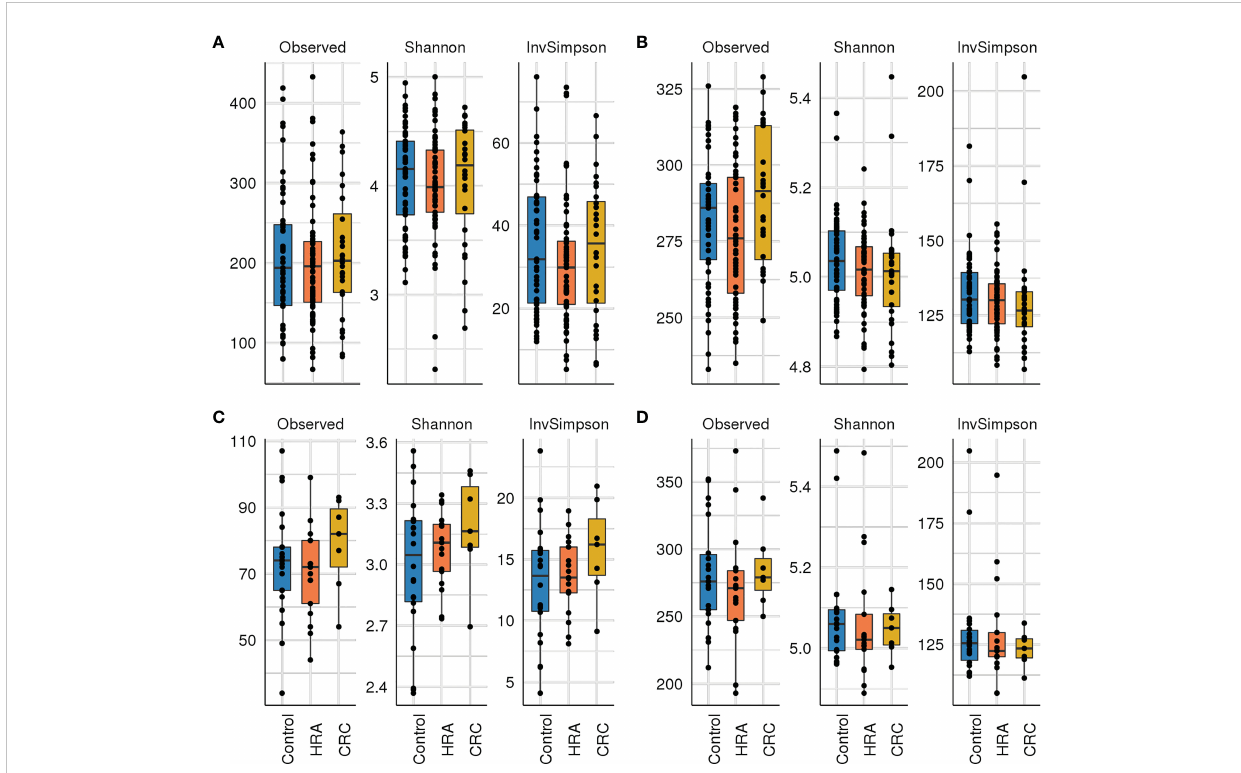
FIGURE 3 Alpha diversity: box plots with taxa/pathway richness (observed), Shannon, and inverse Simpson (InvSimpson) diversity indices in CRC, HRA, and controls for (A) amplicon sequence variants from 16S sequencing data, (B) estimated MetaCyc pathways derived from 16S data, (C) species abundance based on metagenome shotgun sequencing, and (D) MetaCyc pathways based on metagenome shotgun sequencing. No signi fi cant ( p > 0.05) associations were identi fi